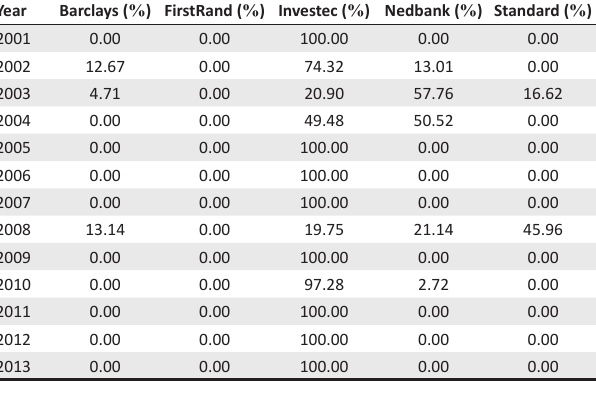
TABLE 1: Systemic risk index contribution ( % ) of each South African bank.